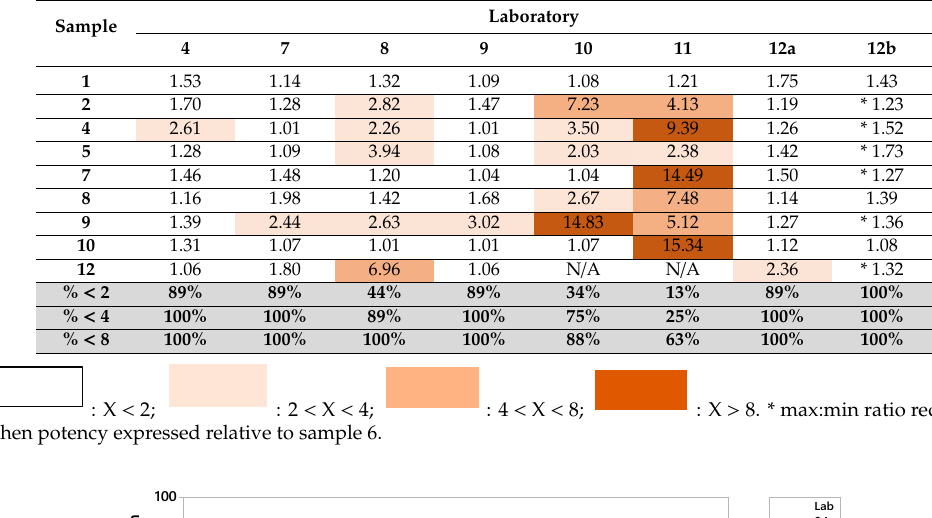
Table 2. Inter-lab variability: Fold-change of laboratory geometric mean ED50 estimates from the overall study median ED50 estimate for each sample. Sample Table 3. Fold-change of laboratory geometric mean potency estimates from the overall median potency estimate for each sample.